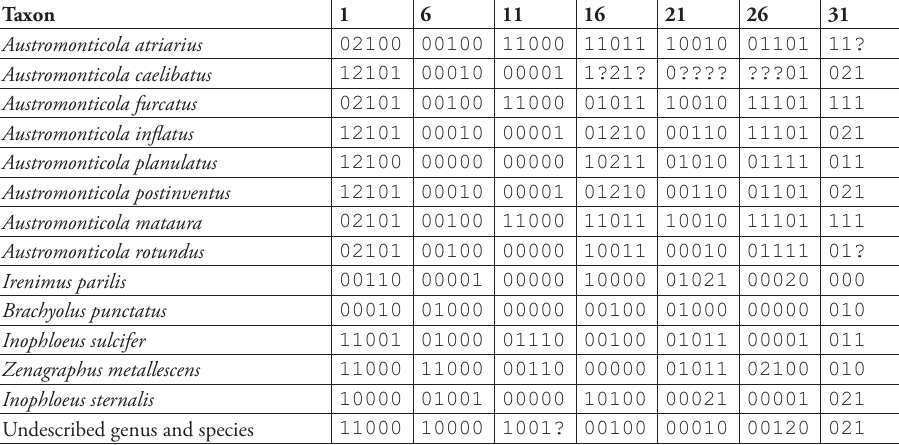
Table 2. Character matrix for cladistic analysis of relationships within Austromonticola .